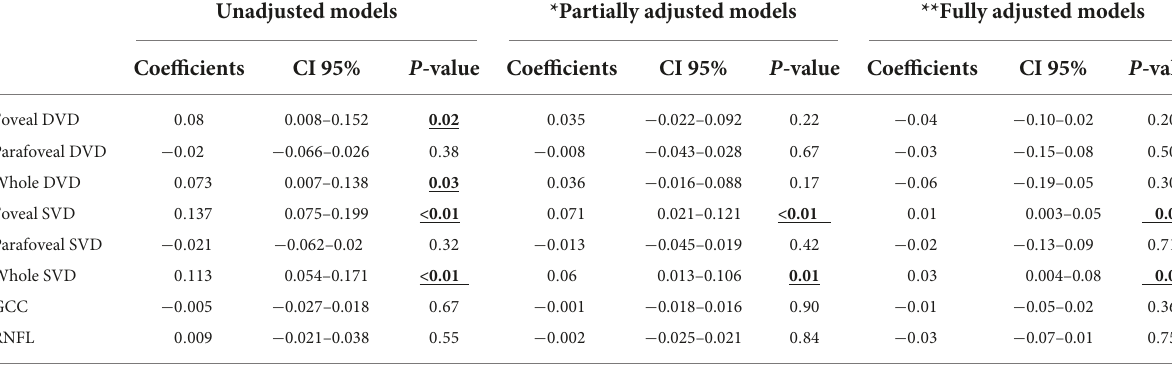
TABLE 3 Linear regression models on Frontal Assessment Battery (FAB) as dependent variable and regressor. Unadjusted